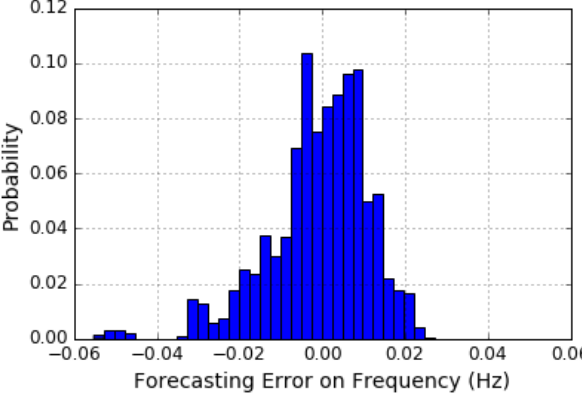
Figure 12. Distribution of f